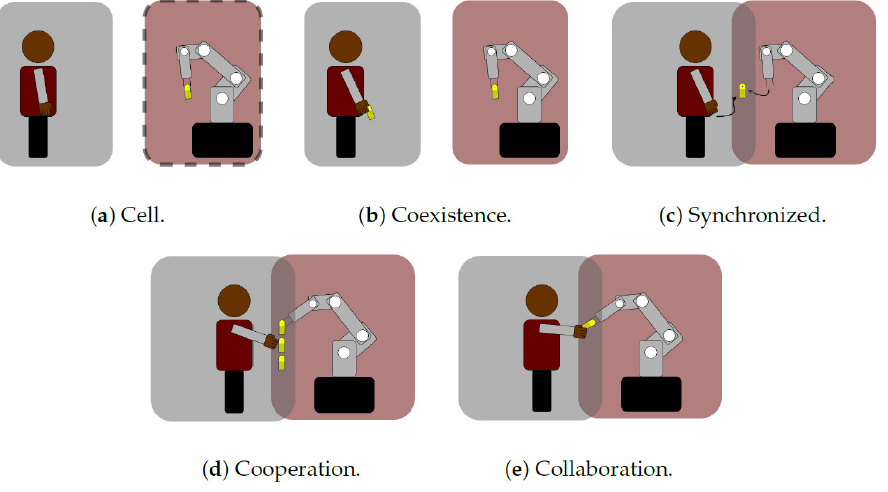
Figure 1. Robot interaction